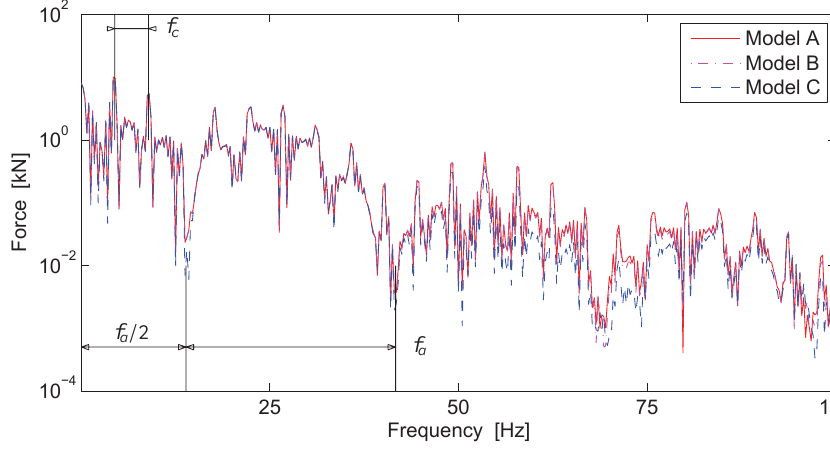
Figure 14. Frequency content of ballast reaction force for each model.